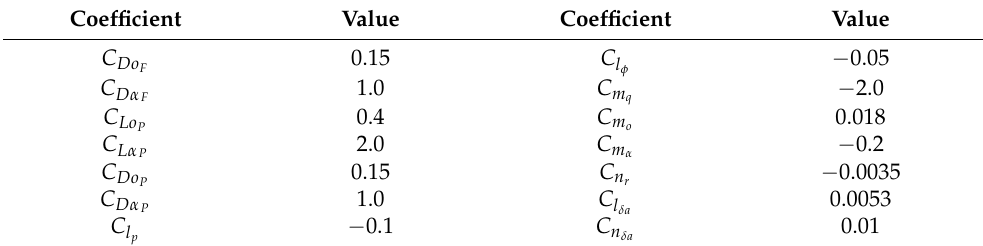
Table 3. Aerodynamics